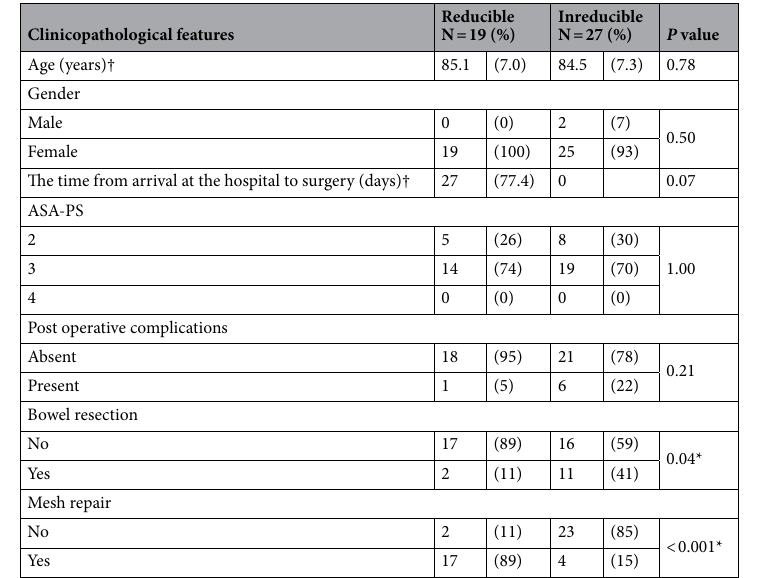
Table 4. Patient characteristics of reducible and irreducible cases. Patients who avoided surgery were not included. *Statistical significance. Student’s t test was used for age, time, and laboratory findings—Fisher’s exact test was used for other parameters. Values in parentheses are percentages unless indicated otherwise † values are mean (SD).